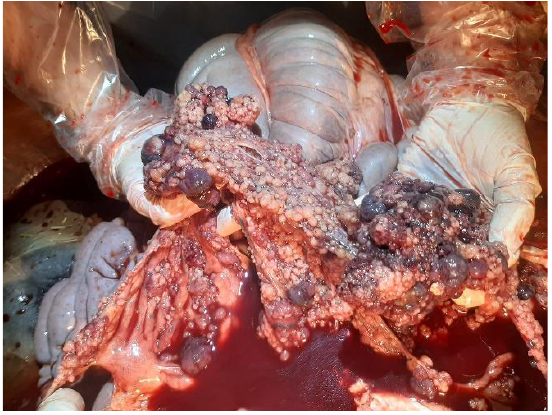
Figure 2. Abdominal cavity: dark red effusion and nodular masses, arranged in clusters.